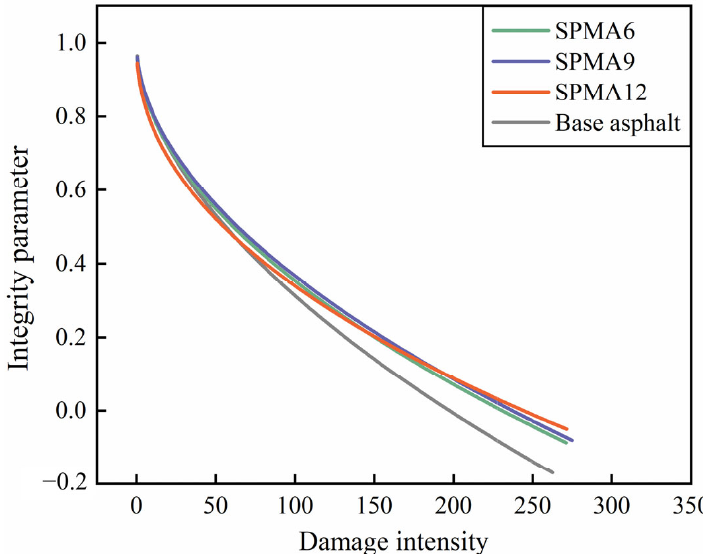
Figure 16. C–D curve of asphalt binders.